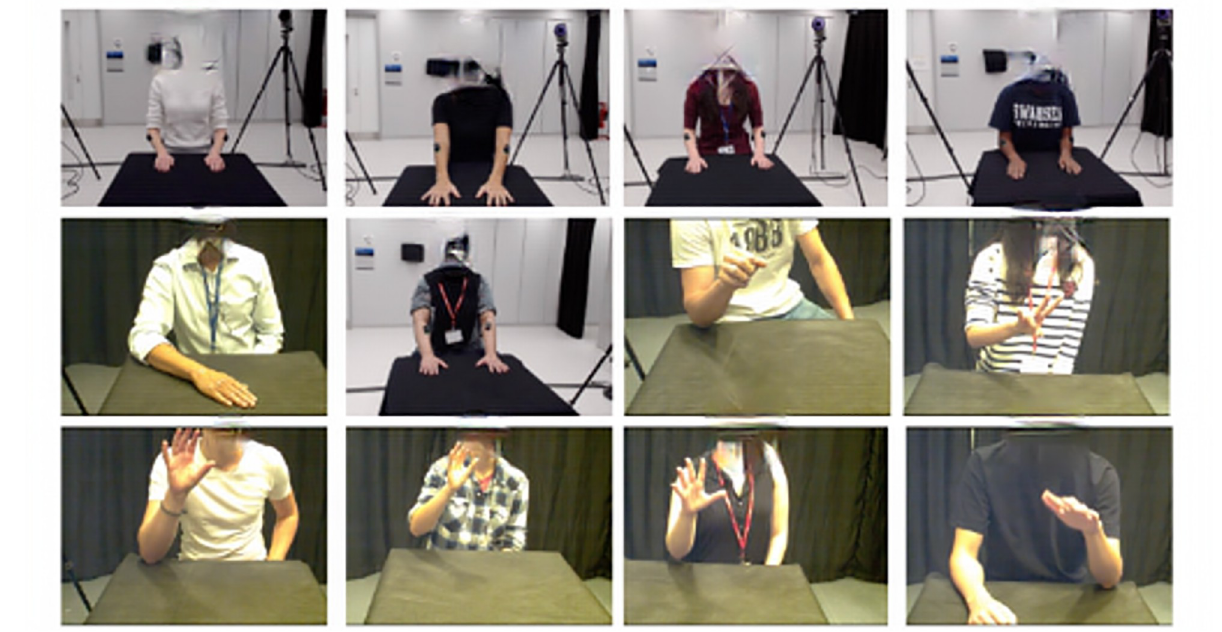
Fig 1. Different hand exercises. Illustrating: A) abduction and adduction, B) metacarpophalangeal flexion, and C) thumb opposition.